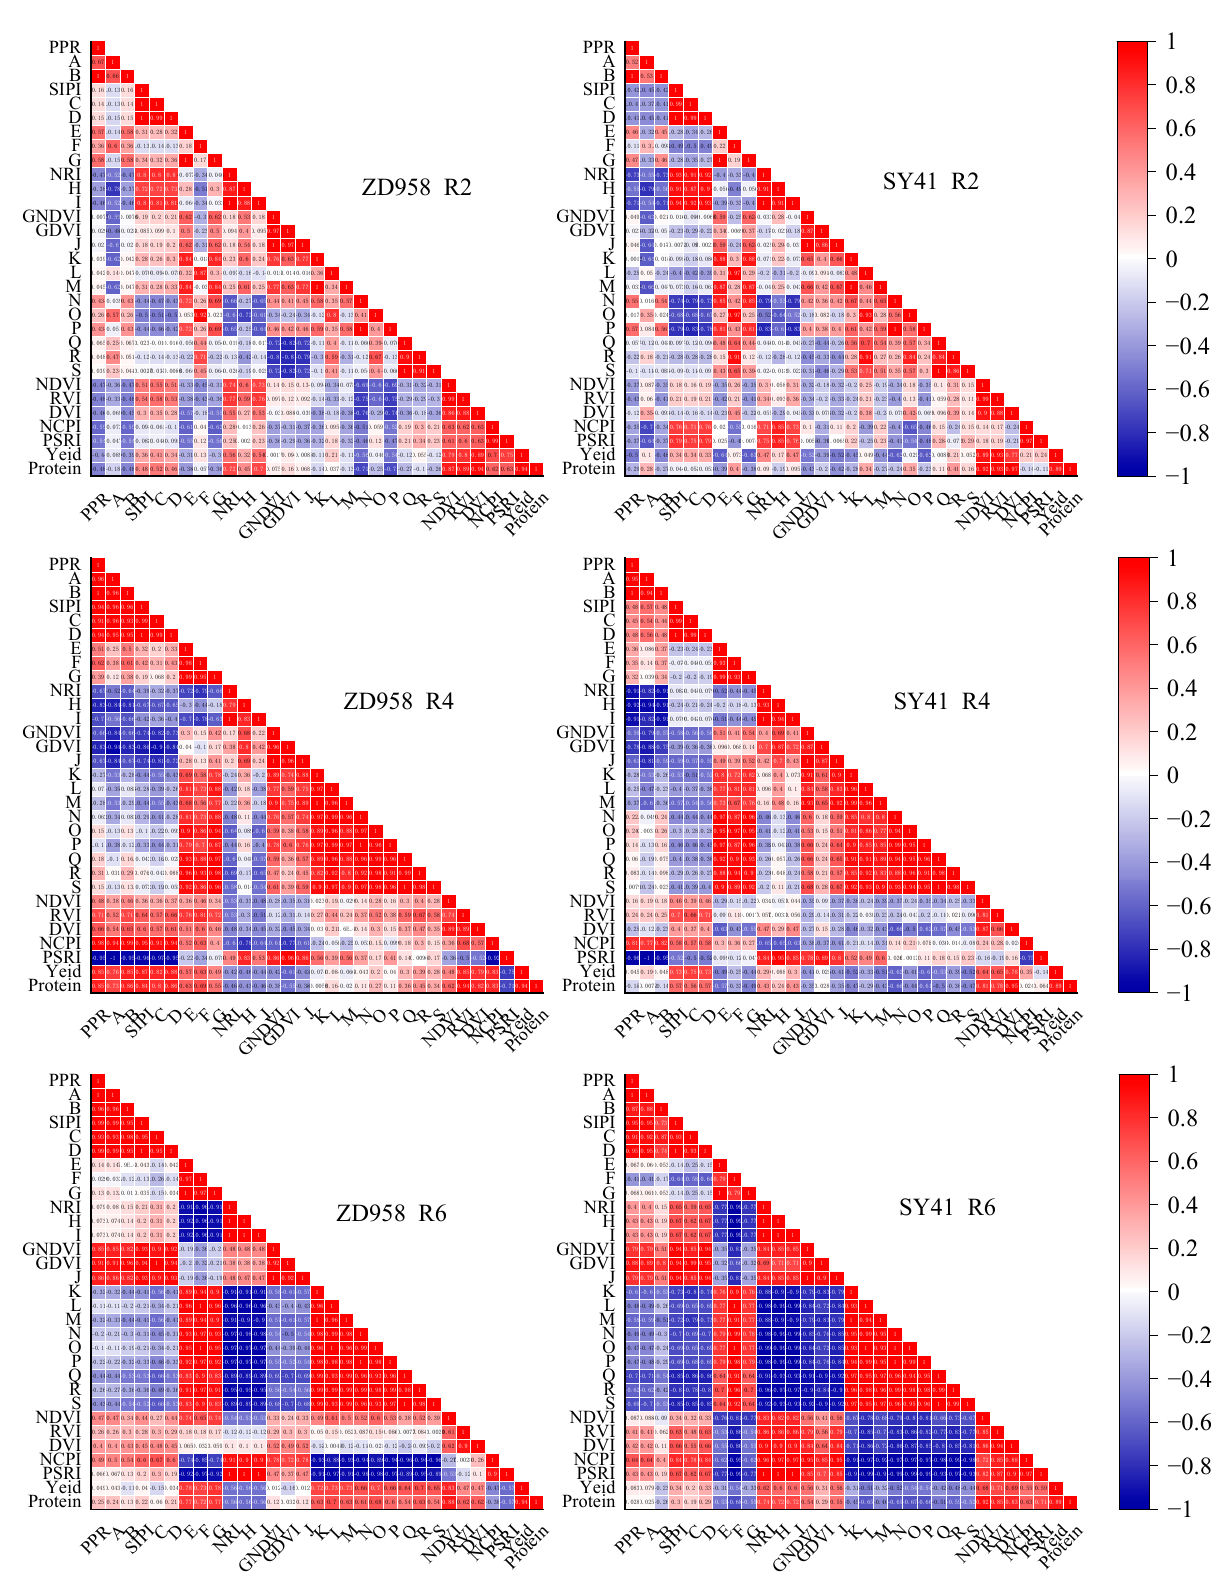
Figure 2. The correlation matrix between all parameters at different growth stages in 2019.